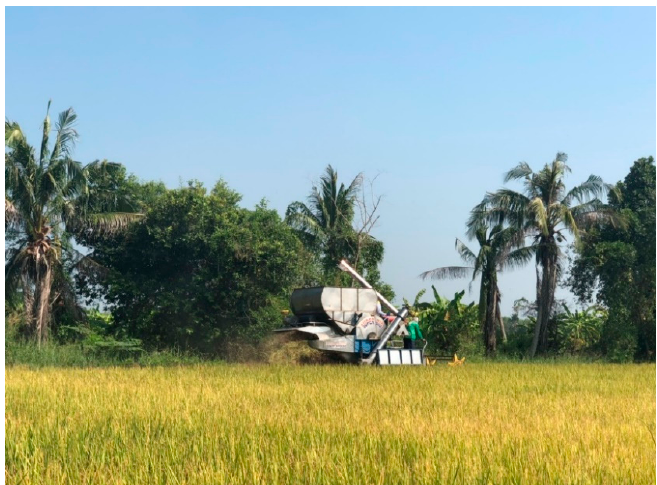
Figure 7. Harvesting. Figure 7.